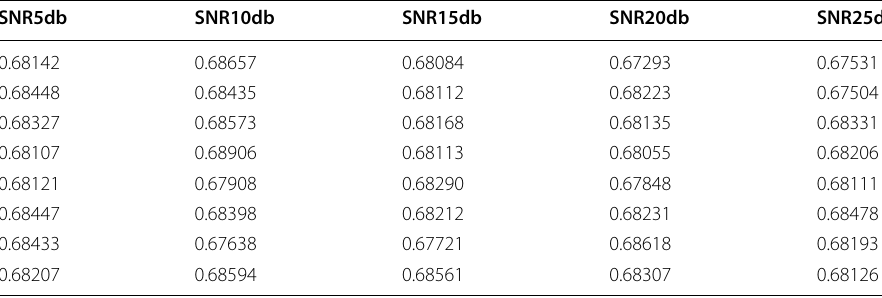
Table 1 The optimal PS factor in AF mode with 8 relays